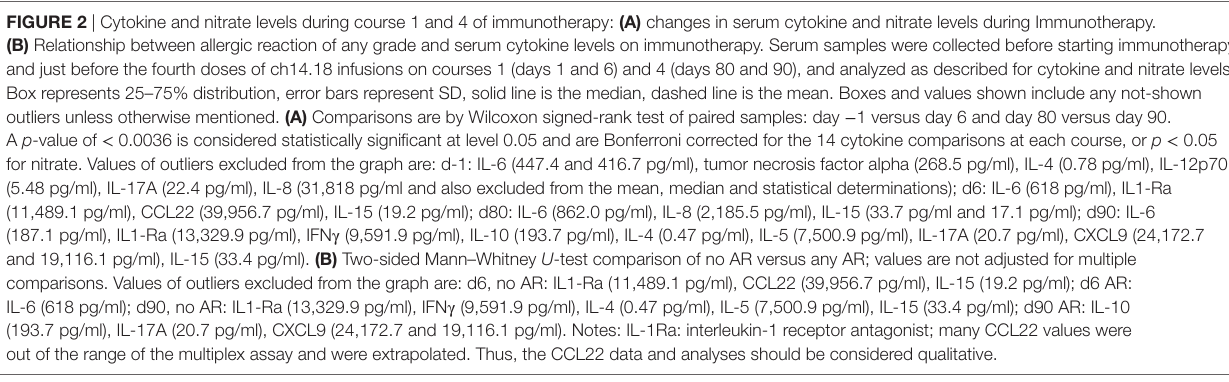
TaBlE 7 | Relationship of cytokine and nitrate levels with severe hypotension in ANBL0931 patients. Course 1, day 6 Course 4, day 90